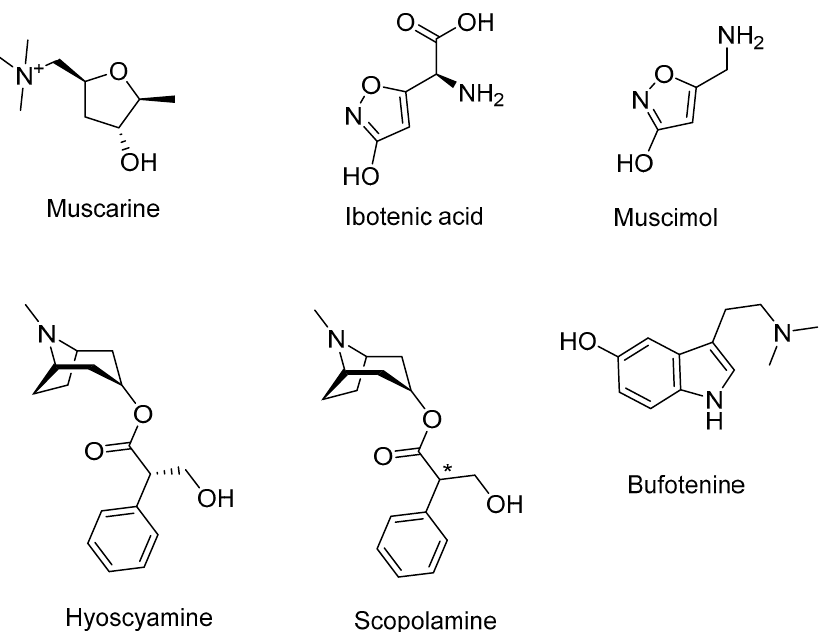
Figure 2. Chemical structures of the main compounds found in A. muscaria